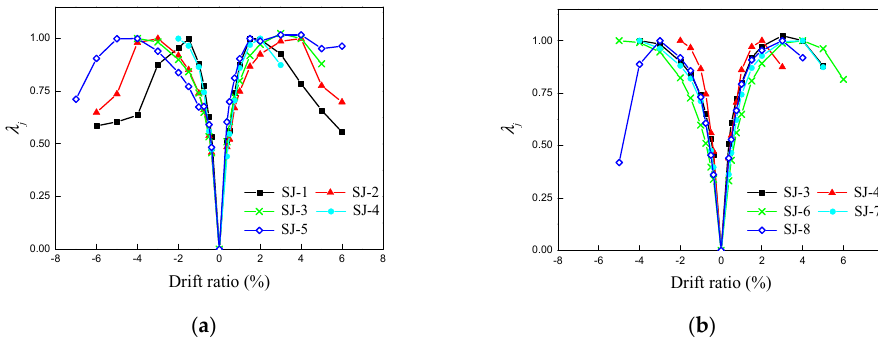
Figure 19. Strength degradation coefficients of the entire loading process. ( a ) Specimens SJ-1 through SJ-5; ( b ) Specimens SJ-3, SJ-4, SJ-6 through SJ-8.